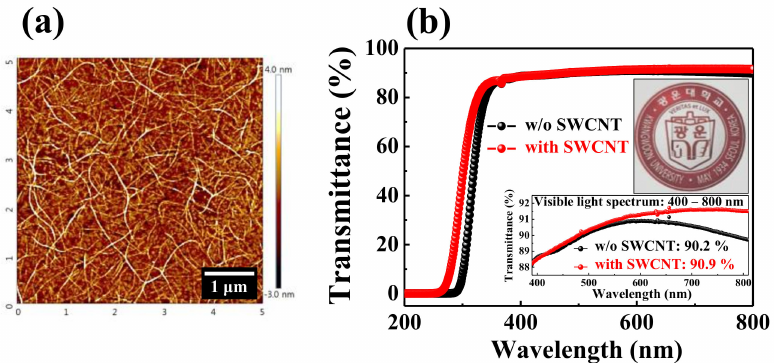
Figure 2. ( a ) Topographic image of the SWCNT random network observed with an atomic force microscope (AFM) (5 × 5 µ m 2 ). ( b ) Optical transmittance spectra of the resistive switching (RS) layer w/o and w/ the embedded SWCNT random network on the glass substrate. The insets depict the optical transmittance in the visible-light wavelength spectrum (400–800 nm) and photographic image of the RS layer w/ the embedded SWCNT random network.